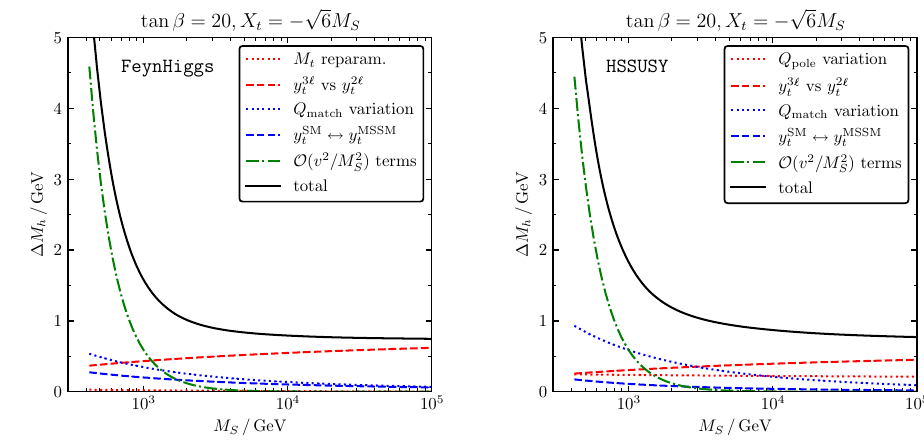
Fig. 4 Estimates of the different sources of theory uncertainty for the EFT calculation, as a function of the SUSY scale M S . The left plot is produced with FeynHiggs , the right one with